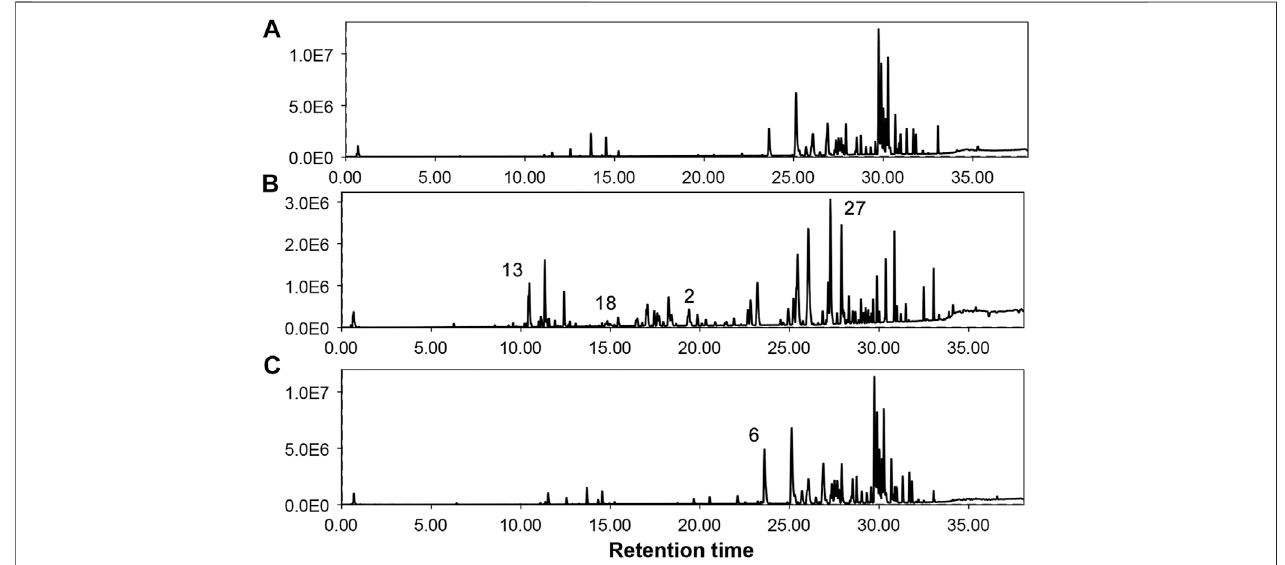
FIGURE2| Totalionchromatogramsofdifferentpartsof G.uralensis obtainedfromUHPLC-QTOF/MSanalysis. (A) (cid:1) Shoots, (B) (cid:1) Leaves, (C) (cid:1) Roots.Numbers over peaks represents different compounds as mentioned in Table 2 .